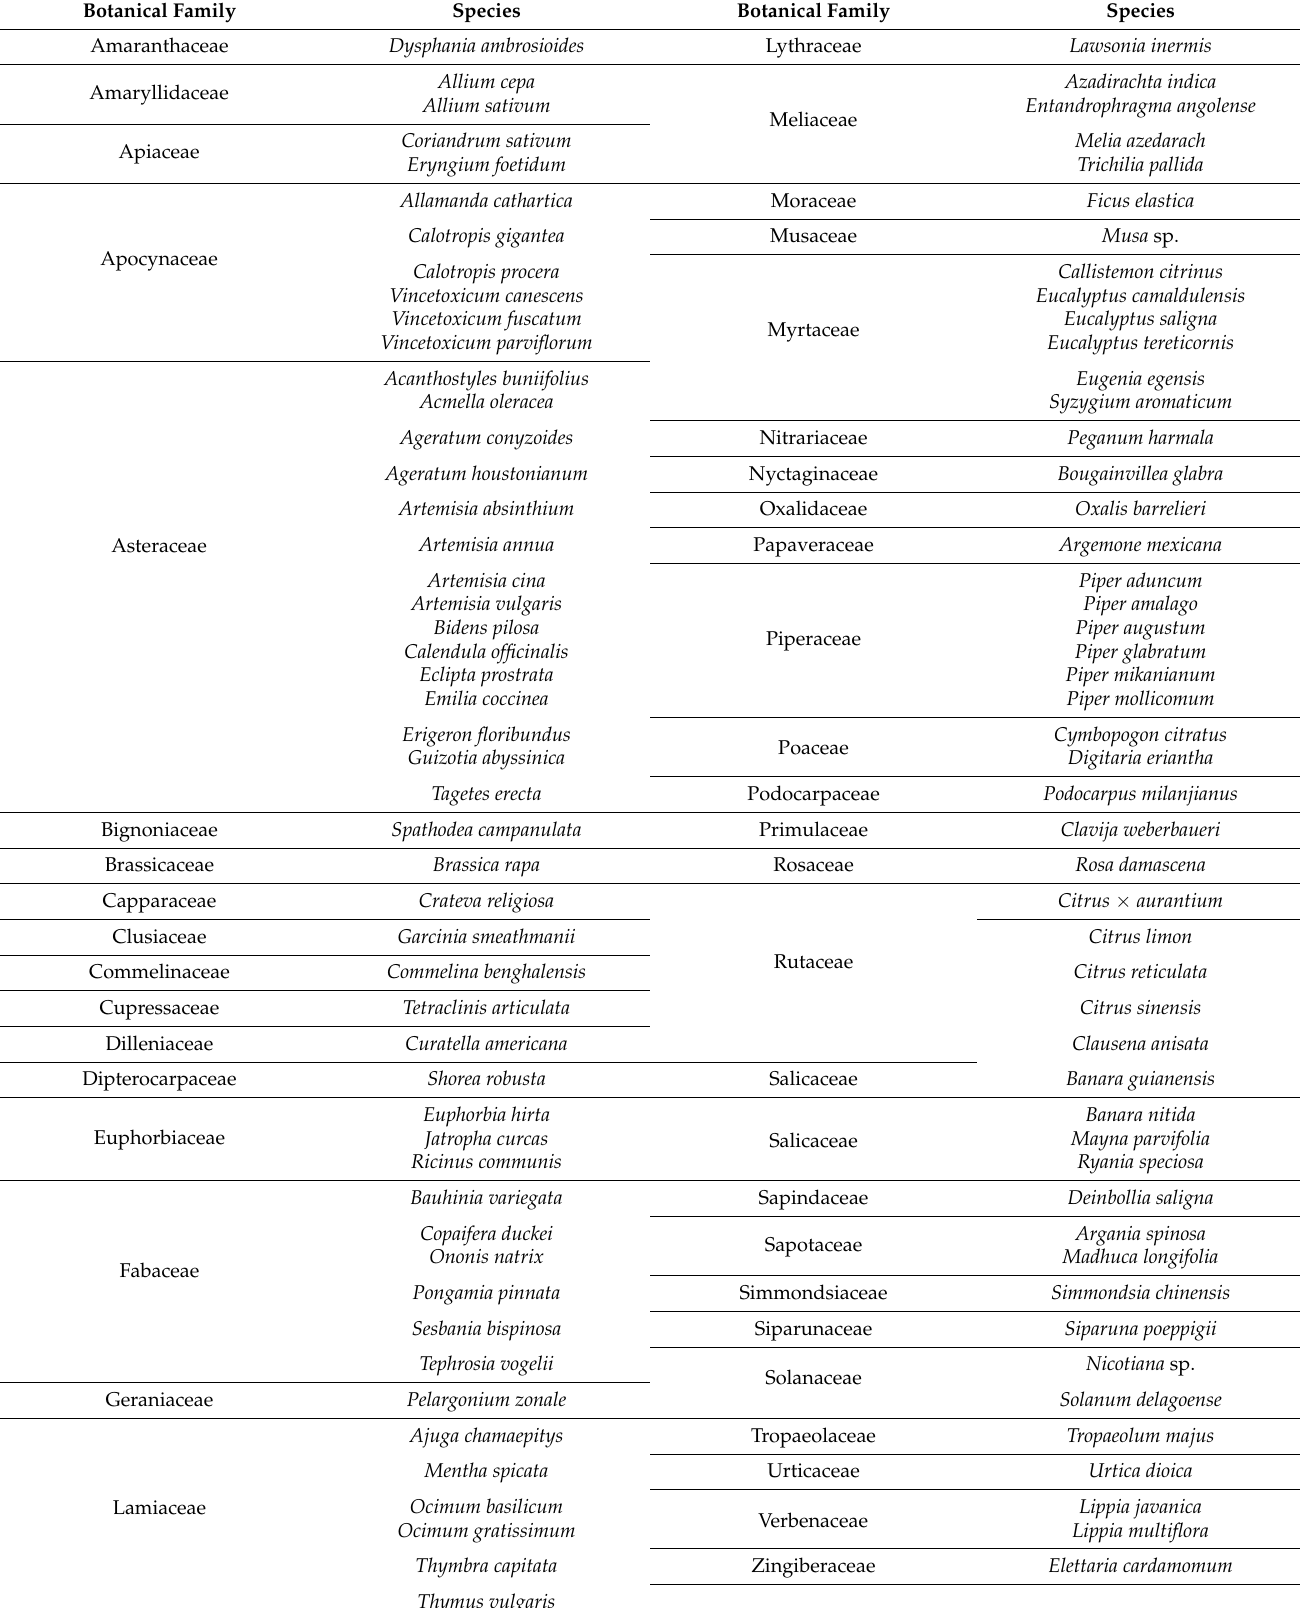
Table 1. Examples in KB of plant genera and species used for the protection of tomato ( Solanum lycopersicon ). Botanical